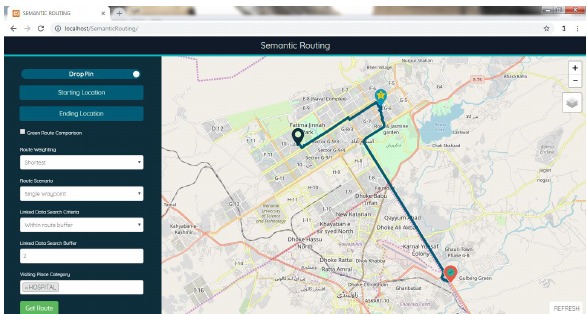
When the user decides the waypoint and clicks on ’View On Map’. Figure 9 shows how the route is finally displayed along- with the location of Hospital waypoint to the user.